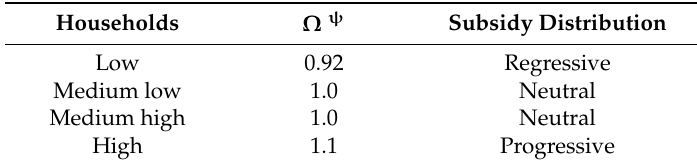
Table 3. Water subsidy targeting indicator ( Ω ) in Mexico